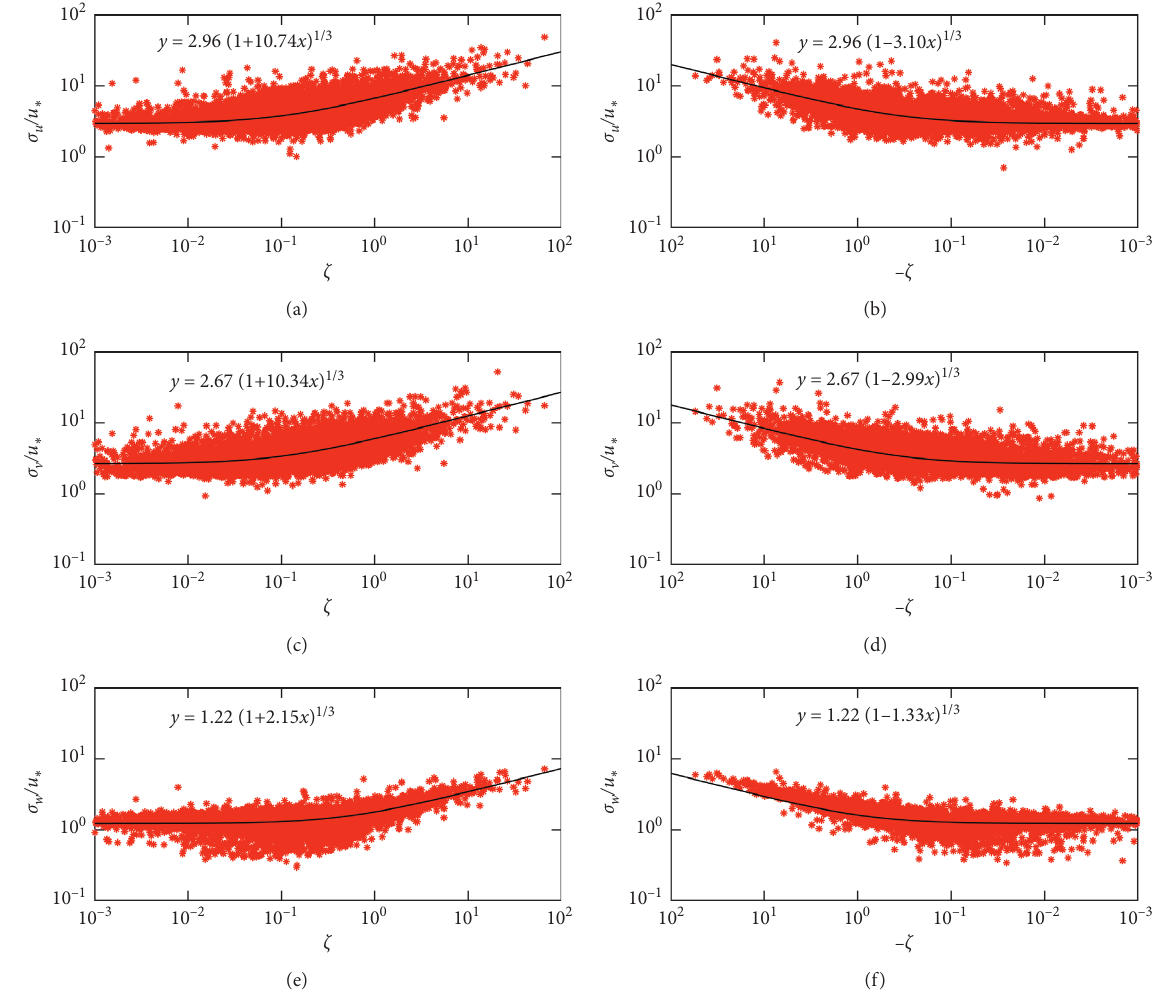
Figure 4: Relationship between the dimensionless standard deviation of the wind velocity u , v , and w components and stability. (a, c, e) for the stable case and (b, d, f) for the unstable